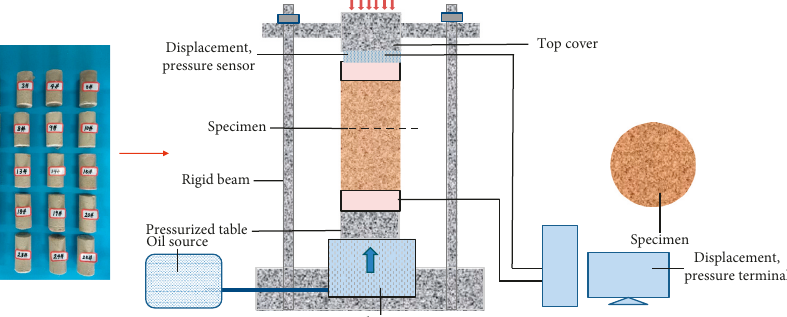
Figure 1: Experimental device.